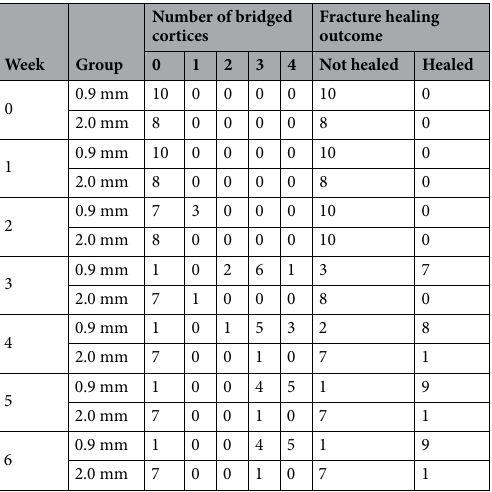
Table 1. Number of bridged cortices per callus evaluated weekly in two perpendicular planes and number of mice with successful fracture healing in the 0.9 mm and the 2.0 mm defect groups (≥ 3 bridged cortices, threshold 395 mg HA/cm 3